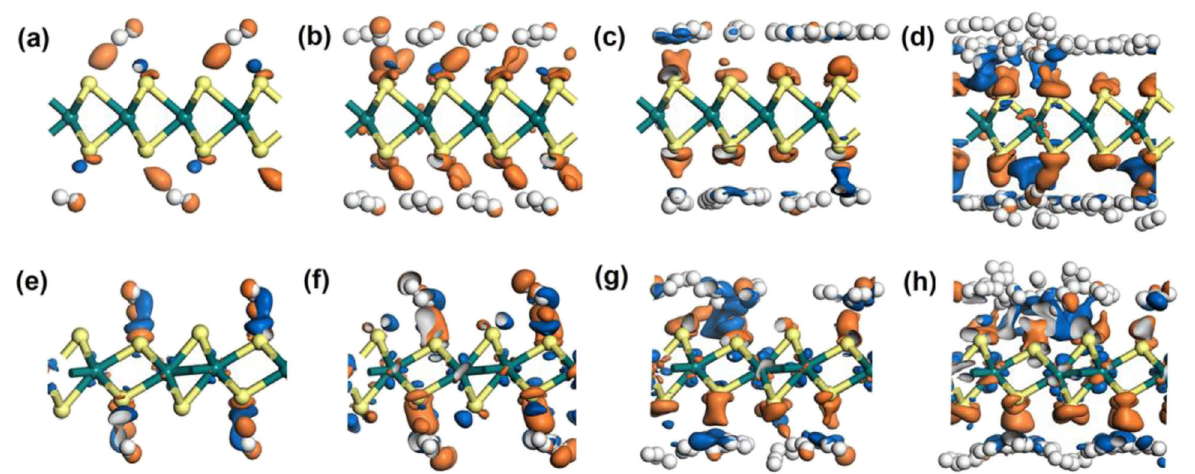
Fig. 5 Electronic difference density of a 4H 2 on 2H-WS 2 , b 16H 2 on 2H-WS 2 , c 32H 2 on 2H-WS 2 , d 64H 2 on 2H-WS 2 , e 4H 2 on 1T ′ -WS 2 , f 16H 2 on 1T ′ -WS 2 , g 32H 2 on 1T ′ -WS 2 , and h 64H 2 on 1T ′ -WS 2 . The isosurface value is taken as 0.002